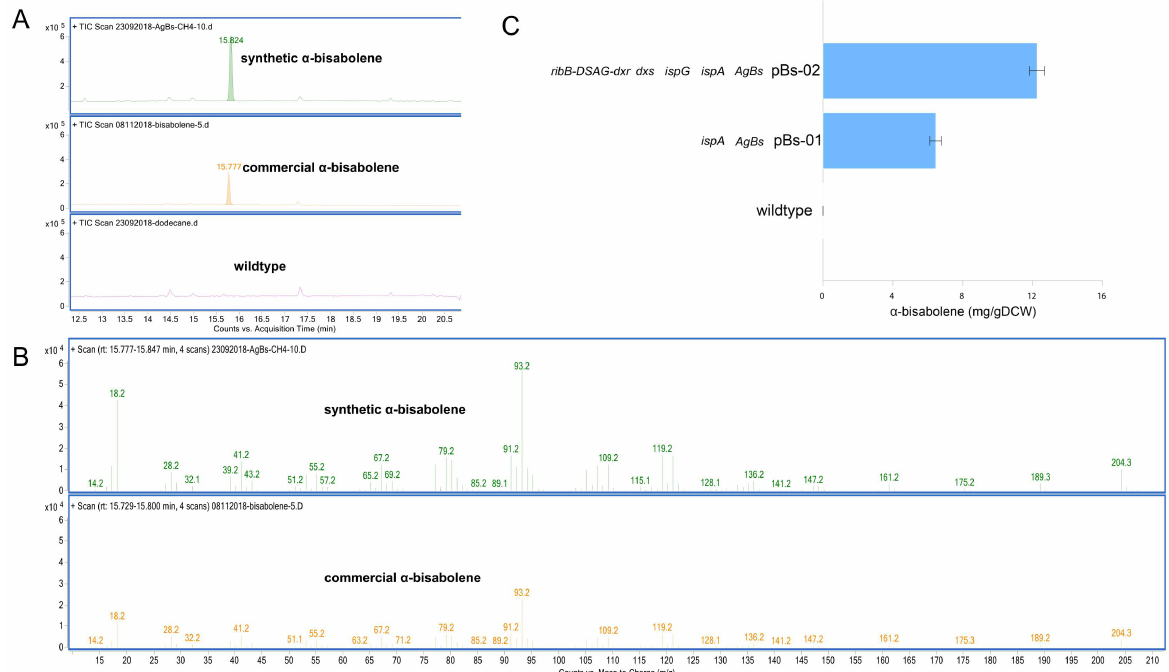
Figure 3. GC-MS chromatogram ( A ), extracted ion GC-MS chromatograms ( B ) of the α -bisabolene standard and synthetic α -bisabolene produced by the pBs-01 strain and α -bisabolene production of the M. alcaliphilum 20Z pBs-01 and pBs- 02 strains using methane (50% v / v ) as the sole carbon substrate ( C ). Analysis of α -bisabolene in the dodecane layer was performed, and the concentrations were compared after 96-h cultivation. The data represent the means from three replicates ± standard